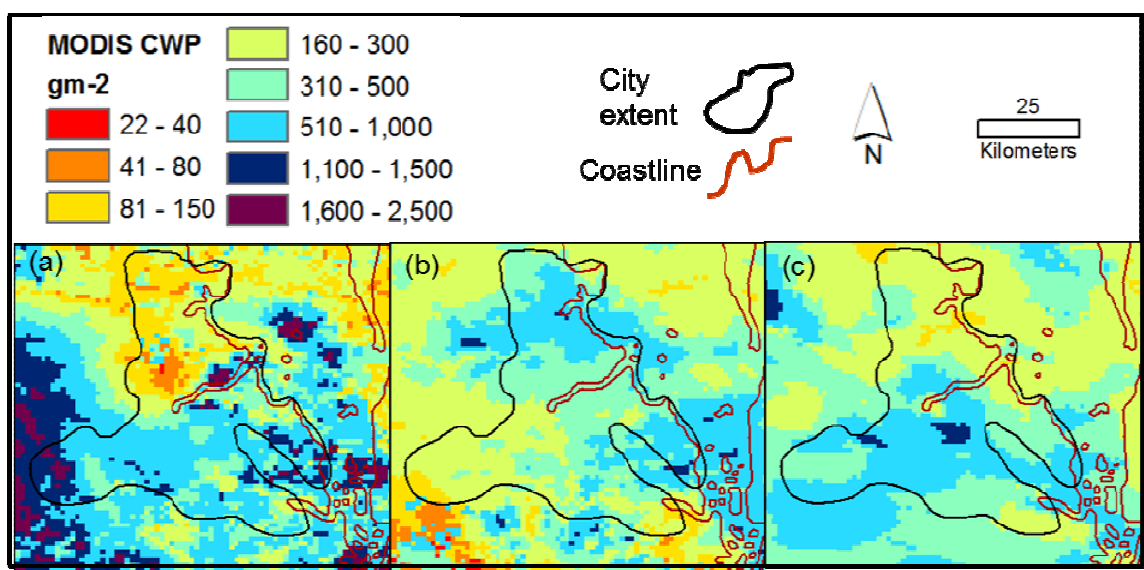
Figure 9. MODIS Cloud Water Path (CWP) for three rain events: ( a ) Sc2009, ( b) Cu/Sc2010 and ( c )